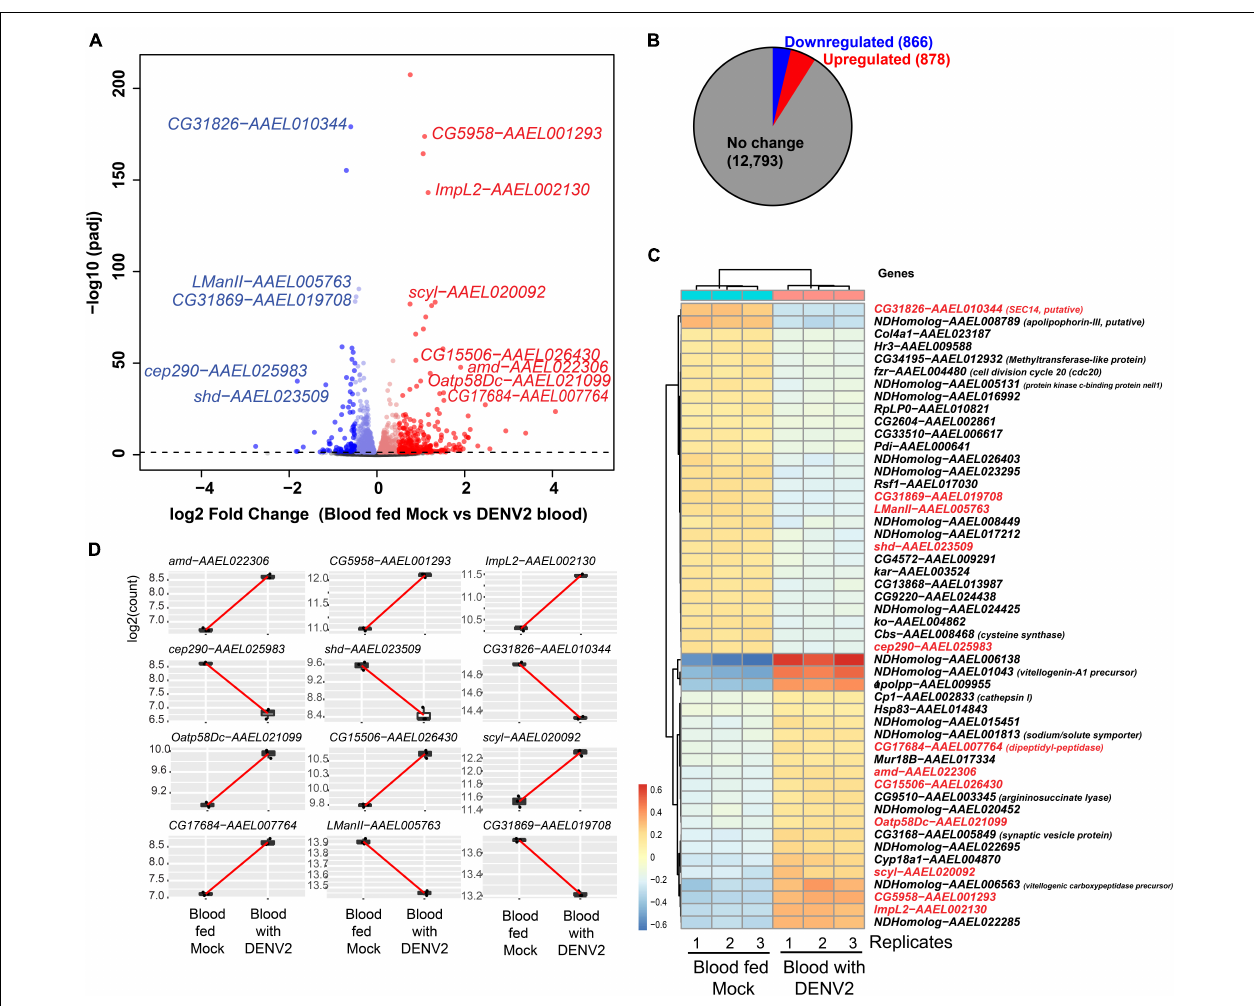
FIGURE 2 | Differential gene expression analysis of Aedes aegypti ovaries transcriptomes 3 days after DENV-2 blood feeding vs. mock blood feeding. (A) Volcano plot of differentially expressed genes (DEGs) from A. aegypti ovaries RNA-seq libraries. (B) Fractional proportion of the ovarian DEGs relative to all other A. aegypti transcripts. (C) Heatmap displaying the top 50 DEGs, and in red text labels are the 12 genes selected for additional downstream studies because the base-mean expression > 200 RPM [or log2(7.6)]. Drosophila gene names are shown except for mosquito-specific genes that are named NDHomolog because there was no Drosophila homologs to be assigned. (D) Highlighting the 12 ovarian gene read counts indicate the robustness of the expression change in the read sequencing counts between replicates and the base-mean expression >